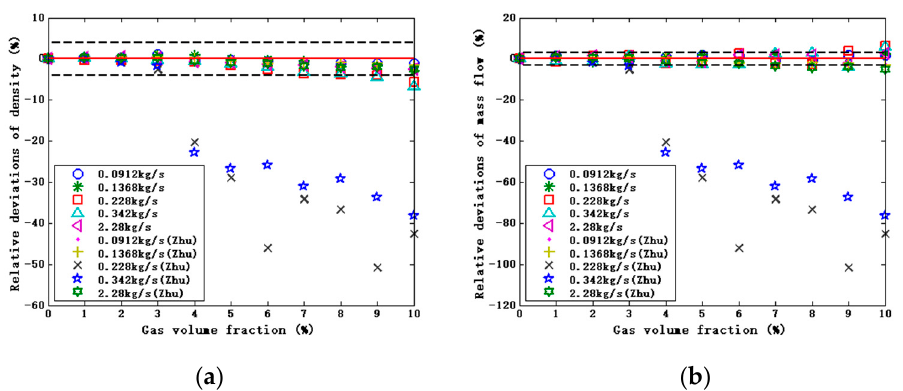
Figure 10. Comparison of density and mass flow deviation correction results of stratified flow between the uniform bubble flow correction model and the proposed correction model. ( a ) Comparison of relative deviations of density. ( b ) Comparison of relative deviations of mass flow.